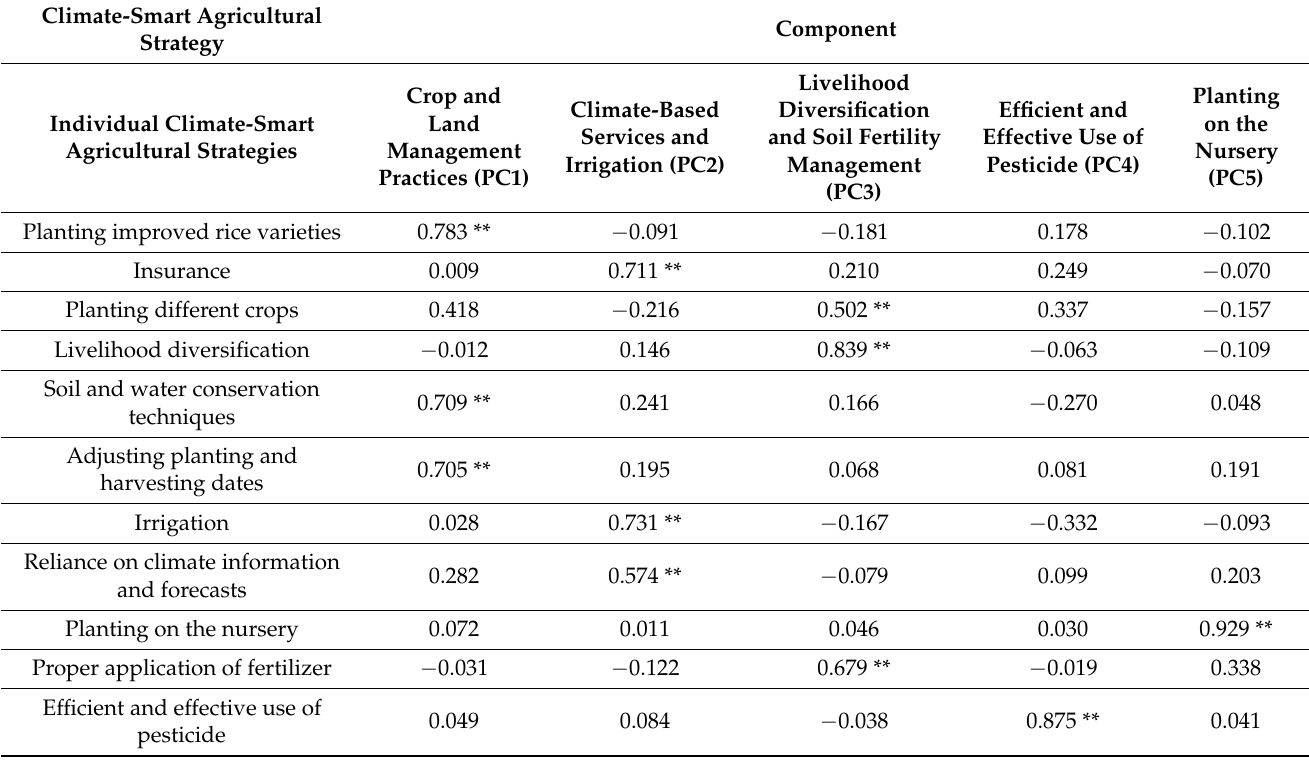
Table 4. Rotated component matrix result of rice farmers’ climate-smart agricultural